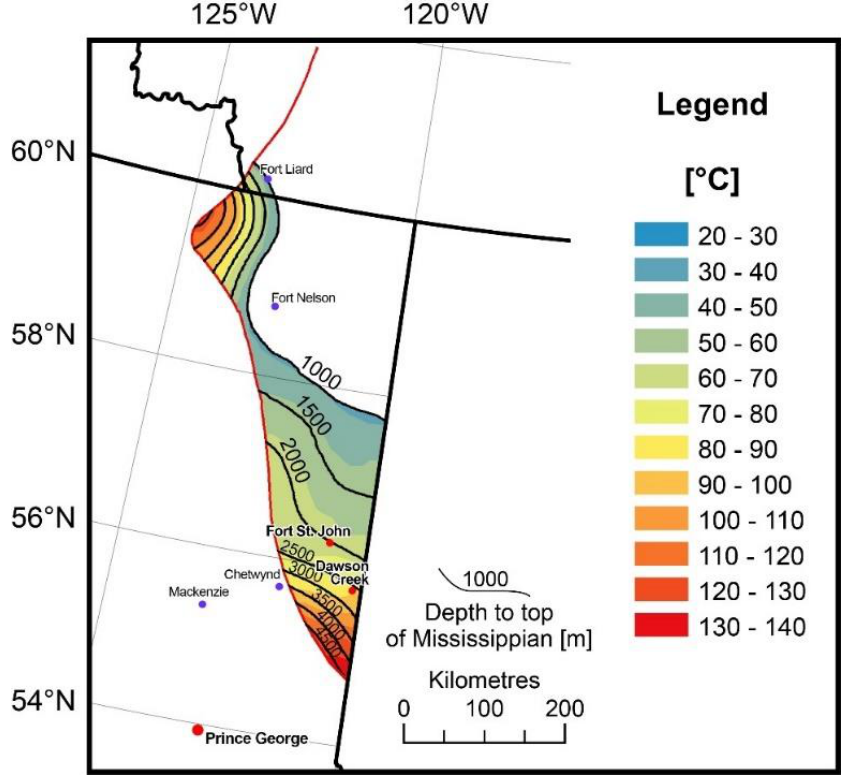
Figure A11. Temperatures top of Mississippian—NE British Columbia S. NWT WCSB.